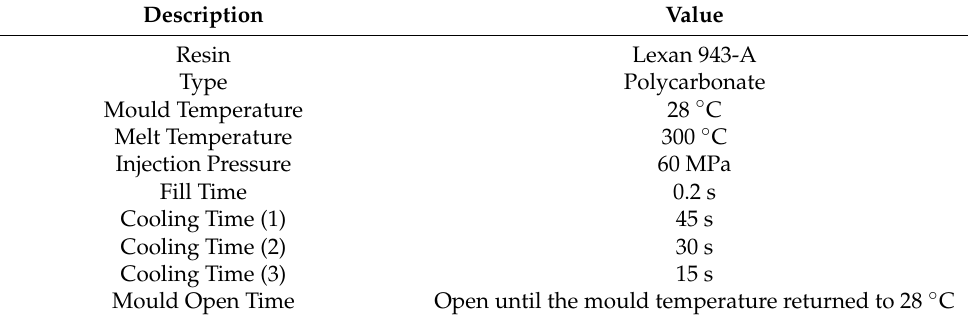
Table 5. Injection moulding process